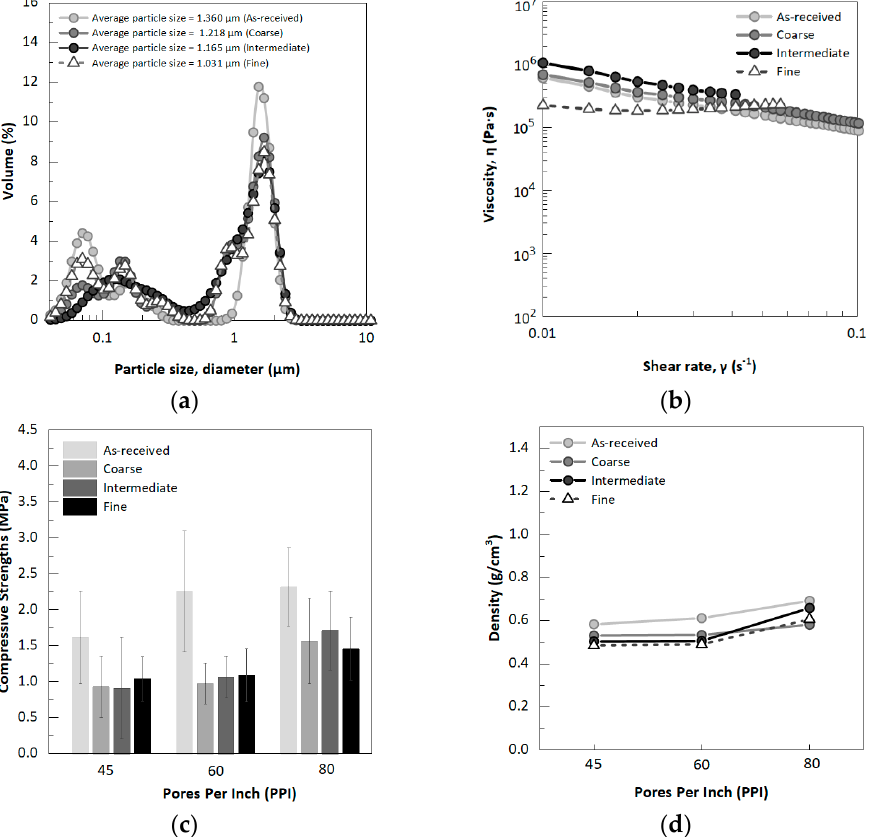
Figure 8. (a) Particle size distributions of ZTA for the as-received, coarse, intermediate, and fine cases. (b) A plot of the viscosity vs. the shear rate of ZTA slurries used to prepare the reticulated porous ZTA: as-received, coarse, intermediate, and fine ZTA particles, and (c) compressive strength outcomes of reticulated porous ZTA specimens prepared from the as-received, coarse, intermediate, and fine ZTA particles (d) density levels .